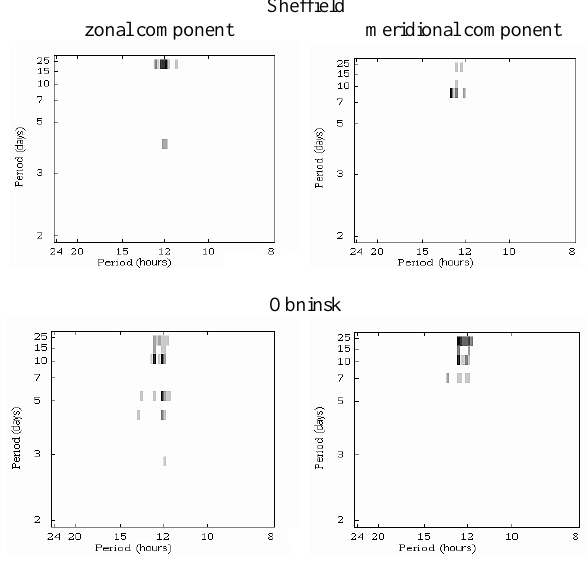
Fig. 9. Bispectra estimated for the hourly wind data of Sheffield and